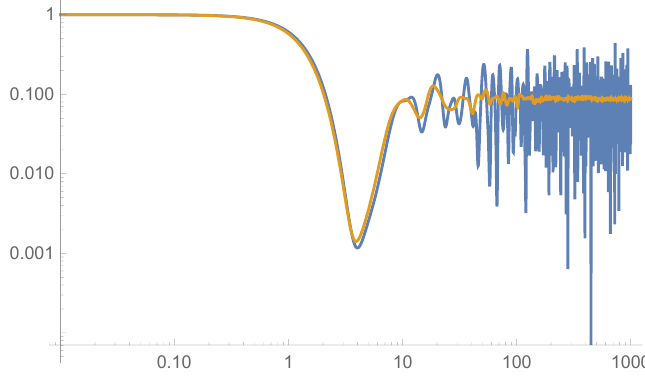
Figure 3 . The progressive time average (3.5) for the GW model with N = 32. (cid:12) = 0 :